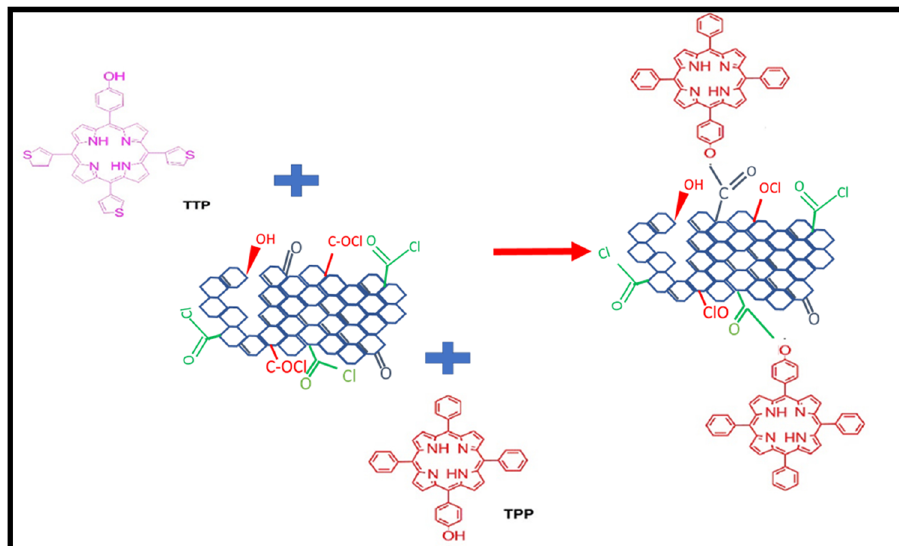
Figure 23: Synthetic route for the formation of TPP - GO - TTP nanohybrids.